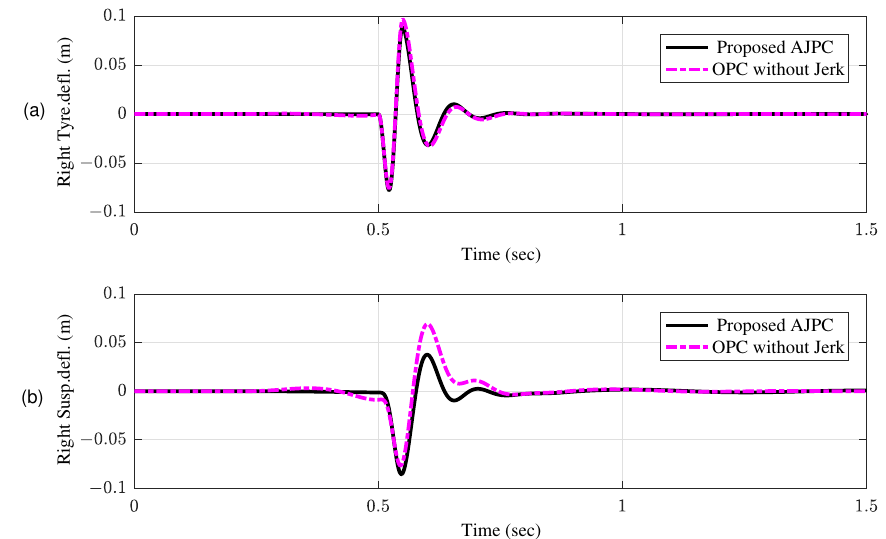
Figure 11. Time domain response of tire and suspension deflection to a bump velocity input using proposed AJPC strategy and OPC strategy without jerk; ( a ) right tire deflection ( b ) right suspension deflection.